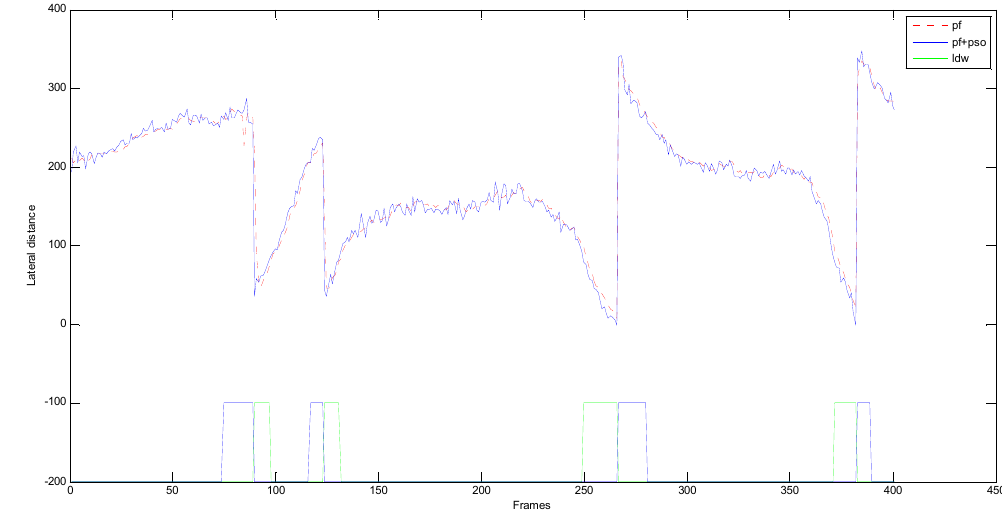
Figure 7. Comparison between particle filter and PSO-PF algorithm on the lateral distance of output lane particles.